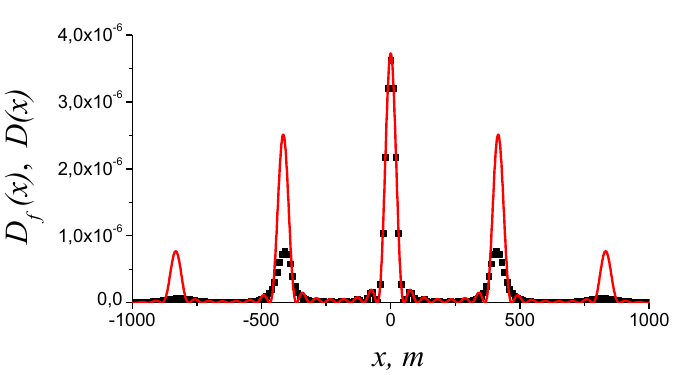
Fig. 4. Cross section ( y=0 ) of directivity patterns D f (x) and D(x) for CW signal (solid red line) and short pulses (black points)